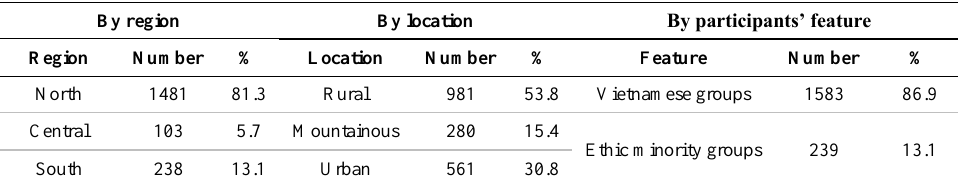
Table 1. Description of the research